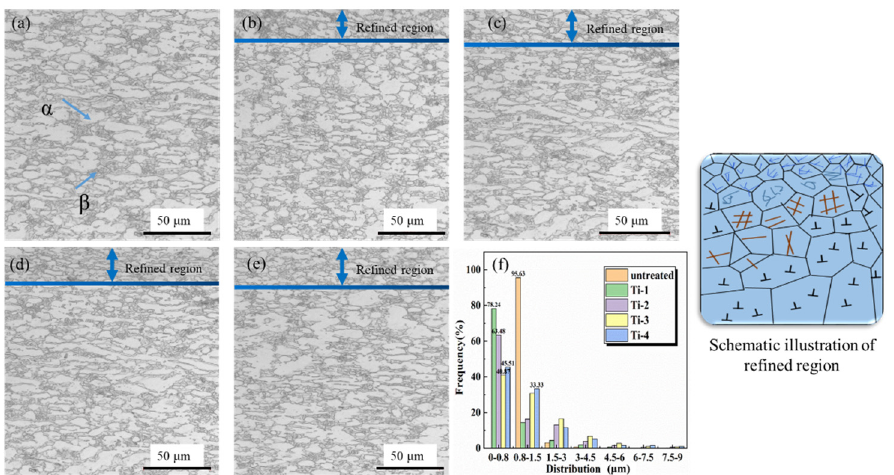
Figure 6. TC6 titanium alloy metallographic structure: ( a ) Untreated sample, ( b ) Ti-1, ( c ) Ti-2, ( d ) Ti-3, and ( e ) Ti-4, ( f ) statistical result of grain size distribution.